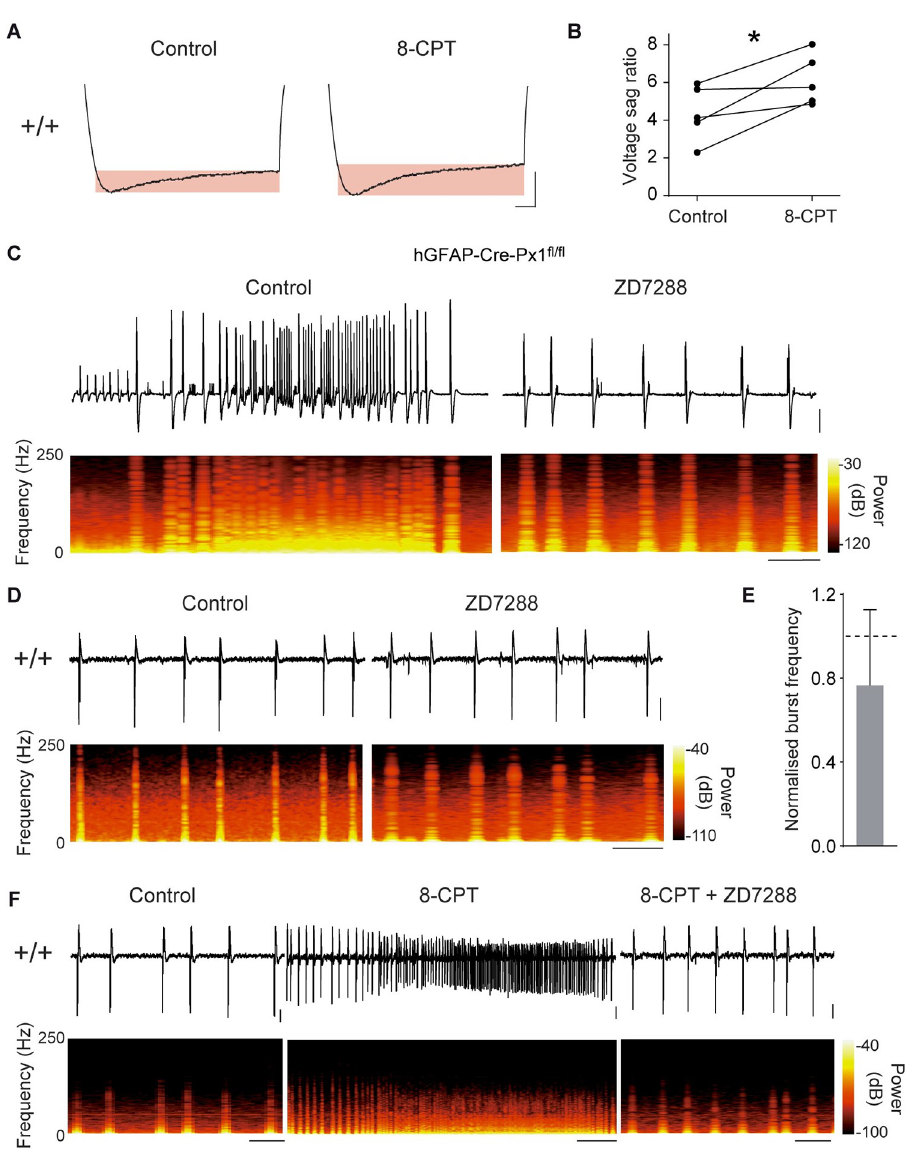
Fig 7. Astrocytic Px1 limits network activity through A1R-mediated modulation of HCN channels. ( A ) Representative traces of the voltage sag ratio in +/+ mice before and after application of the A1R antagonist 8-CPT. Scale bar: 50 ms, 10 mV. ( B ) Quantification of voltage sag ratio, defined as ((Vmin − Vend)/Vmin) × 100 ( n = 5 neurons from 4 mice, paired Student t test). ( C-D ) Representative traces of neuronal network activity recorded in hGFAP-Cre-Px1 fl/fl mice ( C ) and +/+ mice ( D ) before and during application of the HCN channel antagonist ZD7288 (10 μ M; hGFAP-Cre-Px1 fl/fl , n = 5 slices from 4 mice; +/+, n = 6 slices from 2 mice). The corresponding time- frequency plots are shown under the traces. Scale bars, in c: 10 s, 200 μ V; in d: 10 s, 50 μ V. ( E ) Quantification of the change in burst frequency in +/+ mice after application of ZD7288 (paired Student t test). ( F ) Representative traces of neuronal network activity recorded in the same hippocampal slice before and after subsequent applications of 8-CPT and ZD7288 in +/+ mice ( n = 5 slices from 4 mice). The corresponding time-frequency plots are shown under the traces. Scale bars, control and 8-CPT + ZD7288: 10 s, 25 μ V; 8-CPT: 25 s, 25 μ V. Asterisks indicate statistical significance ( � p < 0.05). The data underlying this figure can be found in the S1 Metadata G tab.